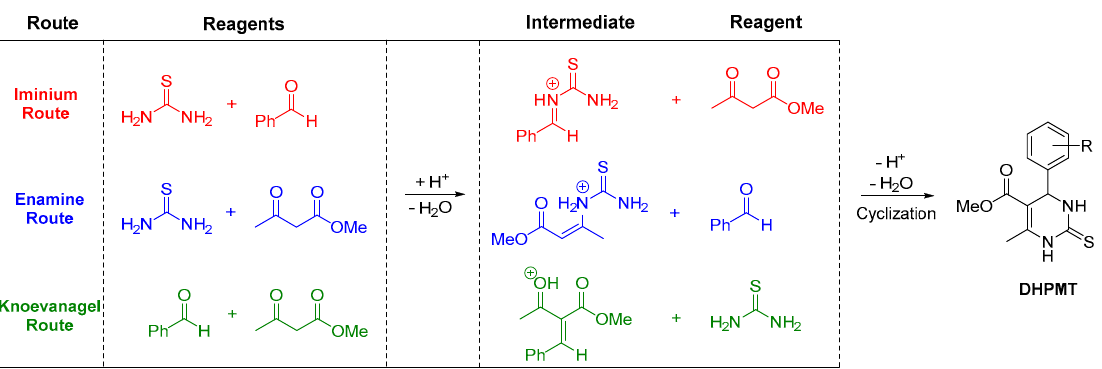
Figure 2. Biginelli pathway reaction: Iminium route, enamine intermediate, and Knoevanagel pathway.